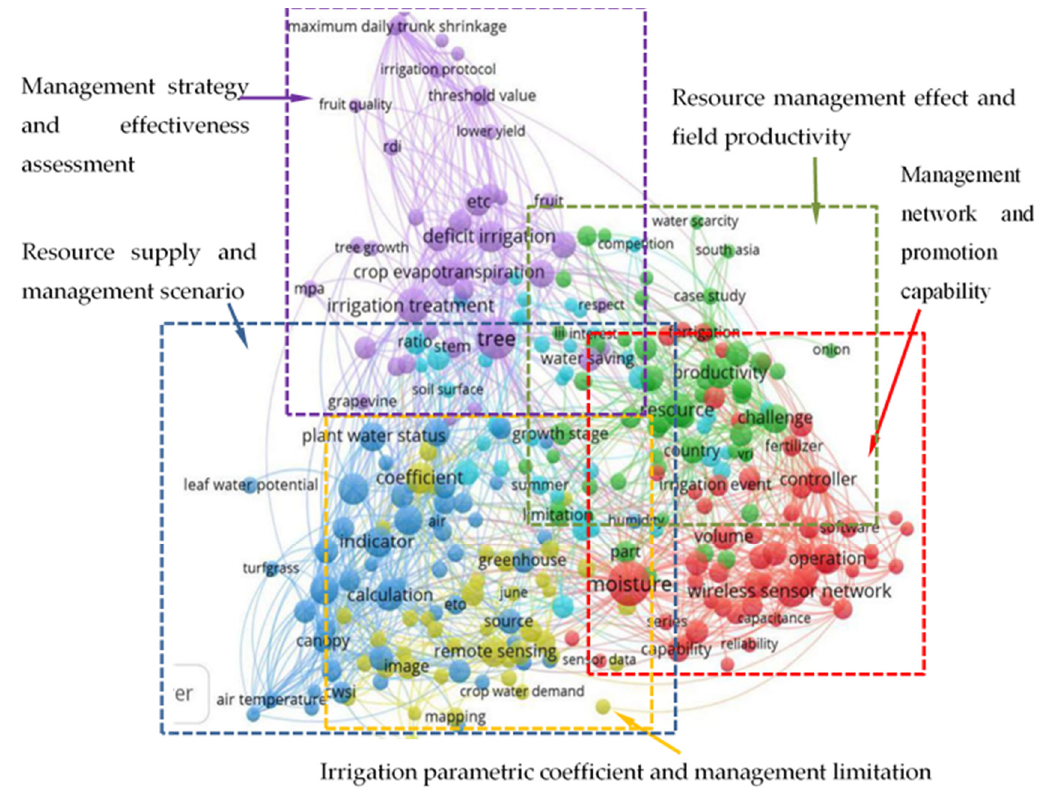
Figure4. Bibliometricsdiagramconcerningintegrativemanagemente ff Figure 4. Bibliometrics diagram concerning integrative management effectiveness of precision irrigation.